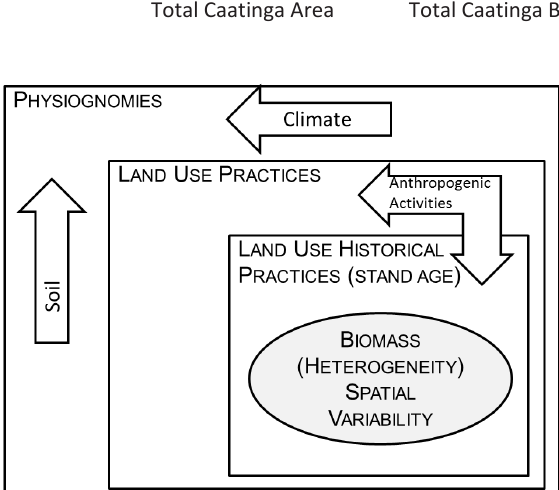
Figure 8. The three levels of biomass heterogeneity forcing identified in the